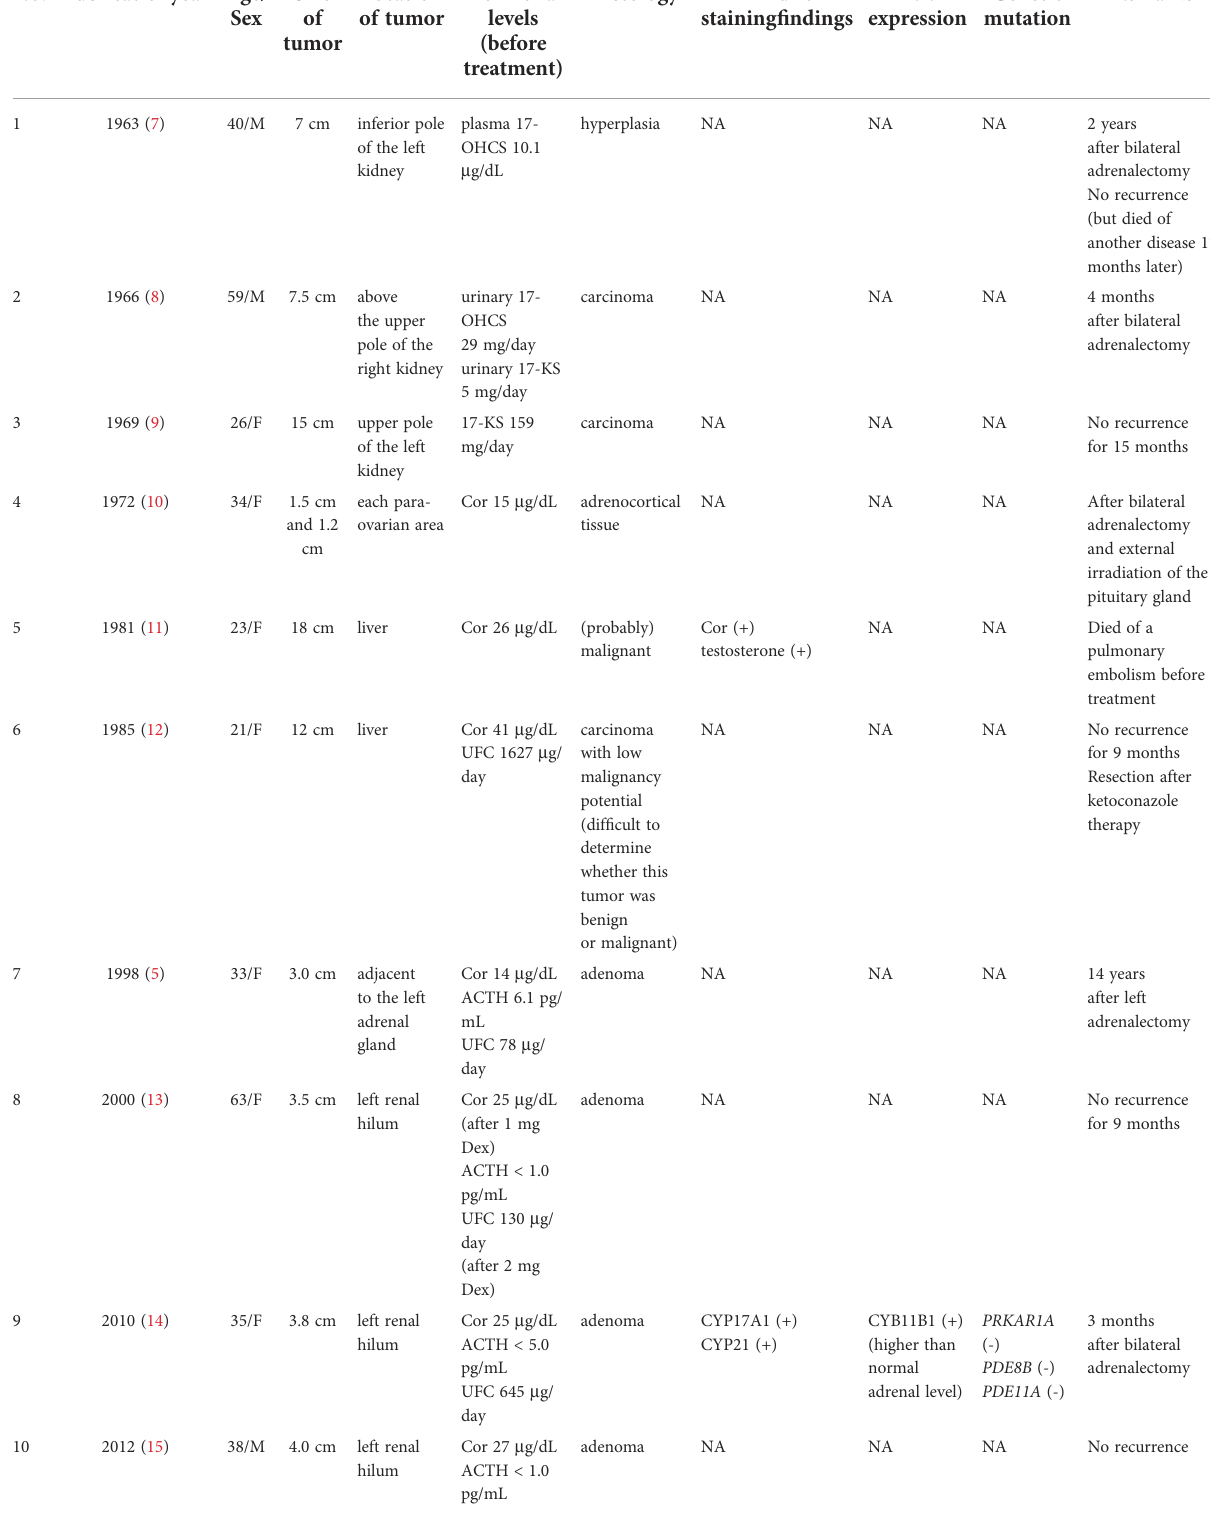
TABLE 1 Reported cases of Cushing ’ s syndrome due to ectopic adrenal